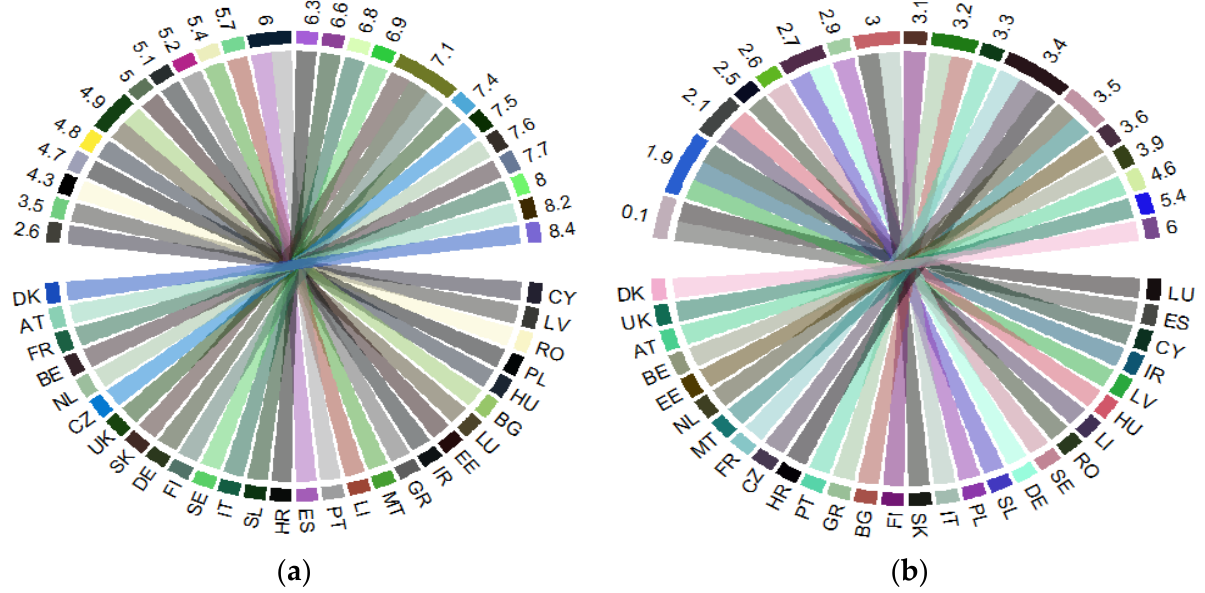
Figure 1. Public health support at the EU level: 2017: ( a ) “Health government expenditure” (% of gross domestic product, GDP) (HGE); ( b ) “Hospital services” (% of GDP) (HS). Source: Own process in R version 3.6.3. (R Foundation, Free Soft-